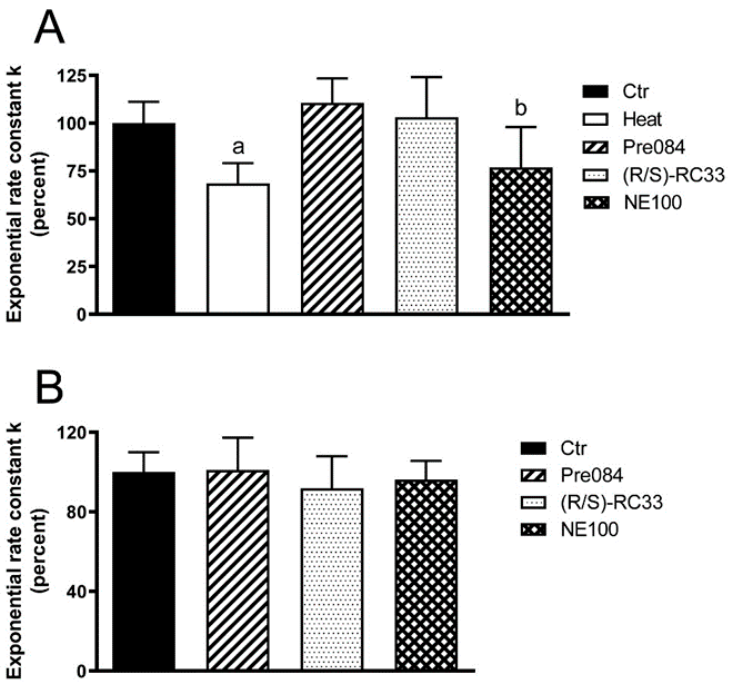
Figure 2. Effect of S1R modulators on the water permeability of HeLa cells in heat-stress conditions ( A ) and in normal non-stressed conditions ( B ). Bars represent the osmotic water permeability of HeLa cells expressed as percent of the exponential rate constant k. Values are means ± SD of 4–15 single shots (time course curves) for each of 4–6 different experiments. ( A ) HeLa cells were exposed to a 150 mOsm osmotic gradient in different conditions: untreated cells (Controls, Ctr); cells treated at 42 °C for 3 h (heat-stressed, Heat); heat-stressed cells pre-treated with test compounds (Pre084, ( R / S )-RC33 and NE100) at 20 µM final concentration. ( B ) HeLa cells were incubated at 21 °C for 3 h with the compounds at 20 µM final concentration and, successively, were exposed to a 150 mOsm osmotic gradient. Controls (Ctr) indicate cells incubated without compounds. a, p < 0.05 vs. Ctr, Pre084, ( R / S )-RC33; b, p < 0.05 vs. Ctr (Repeated measures ANOVA, followed by Newman-Keuls’s Q test).